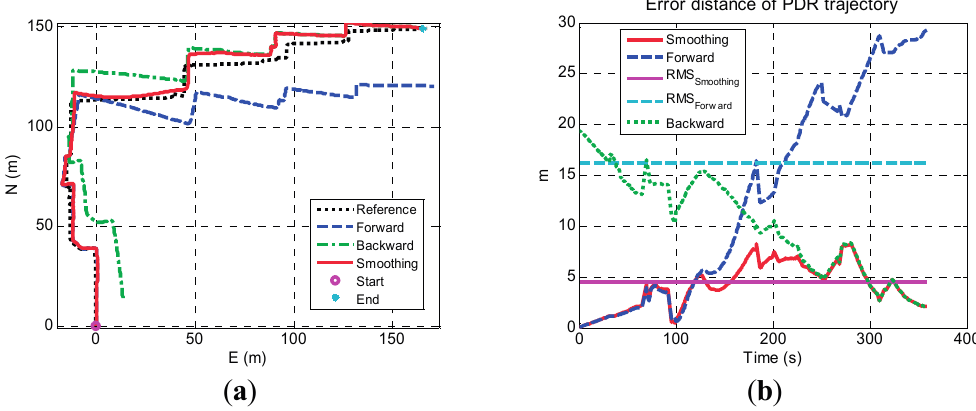
Figure 15. Sensor-based navigation solutions ( a ) and corresponding error distances ( b ).